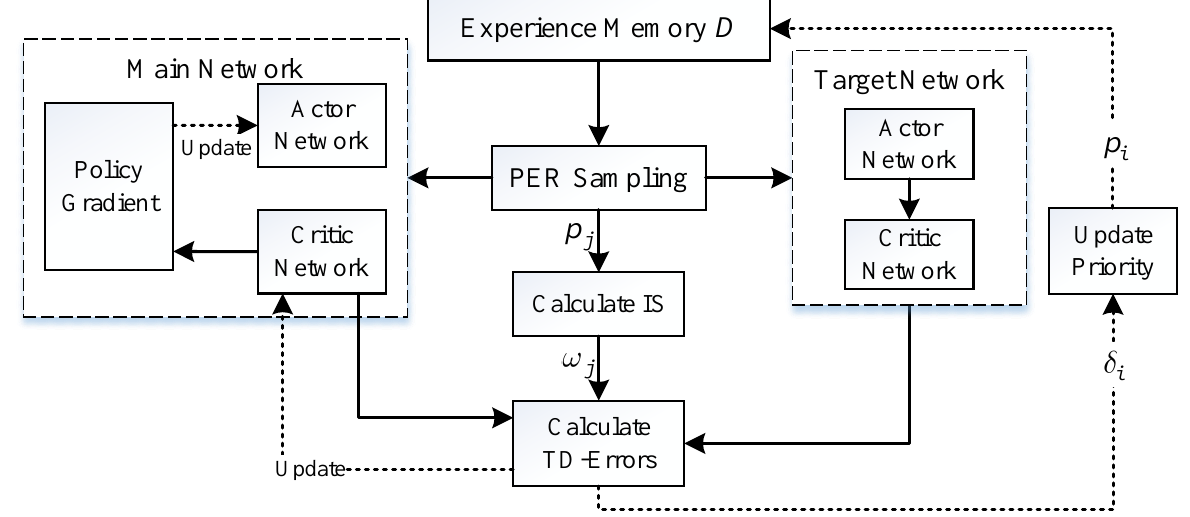
Figure 4. The diagram of Prioritized Experience Replay-Deep Deterministic Policy Gradient (PER-DDPG)’s